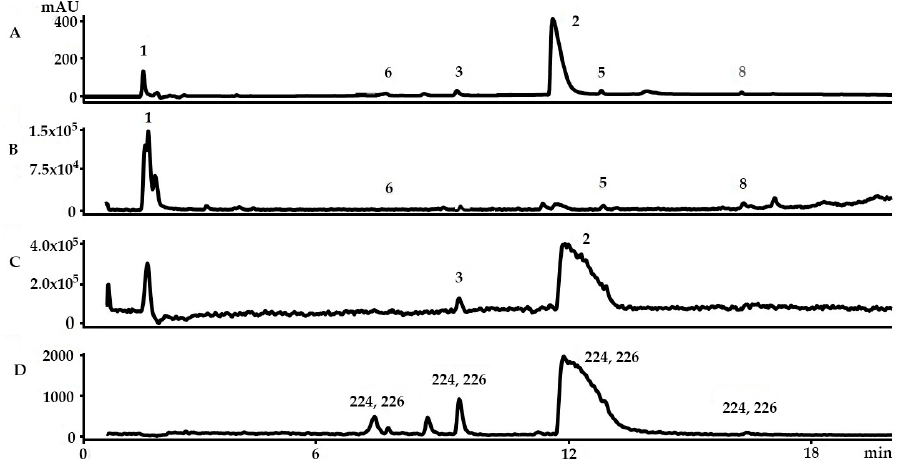
Figure 2. Liquid chromatography–mass spectrometry analysis of an ethanol extract from the Dicathais orbita hypobranchial gland: ( A ) high performance liquid chromatography chromatogram at 210 nm; ( B ) total ion current (TIC) in positive ion mode; ( C ) TIC in negative mode; and ( D ) selected ion monitoring (SIM) for 224 and 226 in equal ratios for bromoisatin isotopic fragment ions Br 79 Br 81 . Numbered peaks based on Figure 1 correspond to ( 1 ) murexine, ( 2 ) tyrindoxyl sulphate, ( 3 ) tyrindoxyl S-oxide sulphate, ( 5 ) tyrindoleninone, ( 6 ) 6-bromoisatin, and ( 8 )